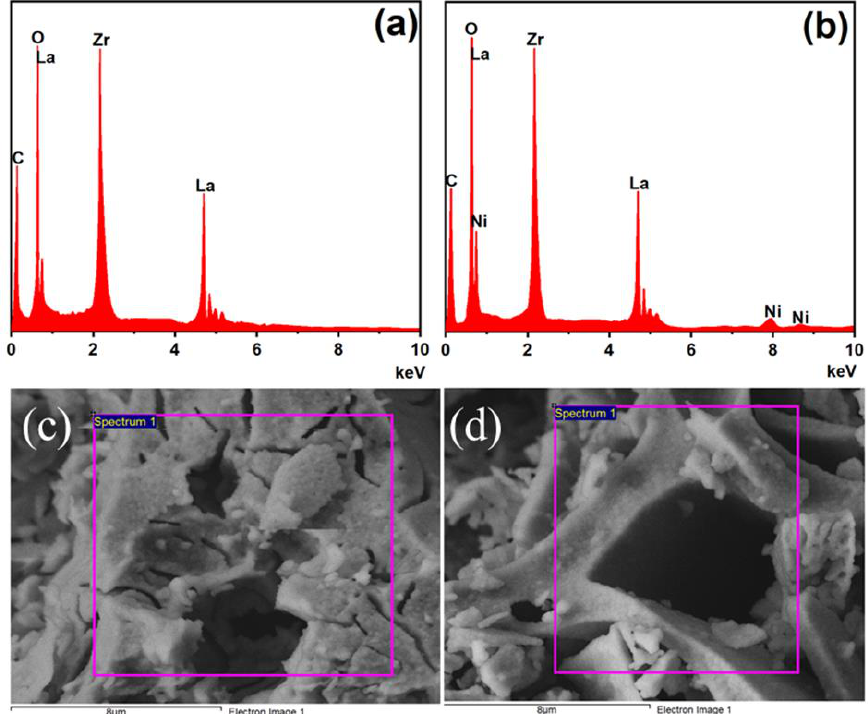
Figure 11. EDS spectra ( a , b ) and the corresponding captured area ( c , d ) of LZ-sg and LZN-sg pyrochlores. Table 5. Chemical composition of of La 2 Zr 2-x NixO 7 pyrochlores by EDS analysis. Weight% Atomic% Sample La Zr